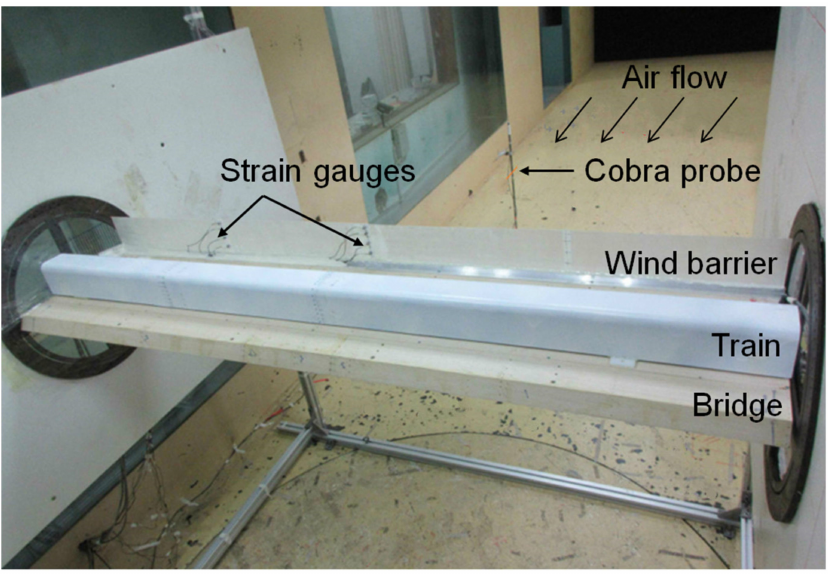
Figure 2. Wind tunnel experiments for the proposed barrier–train–bridge